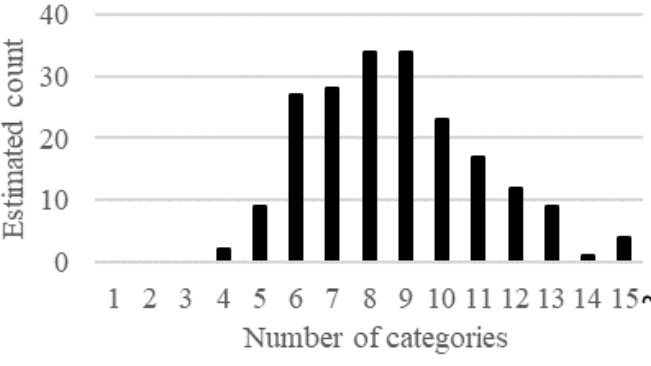
Figure 6. Distribution of the automatic estimation of the number of ticket